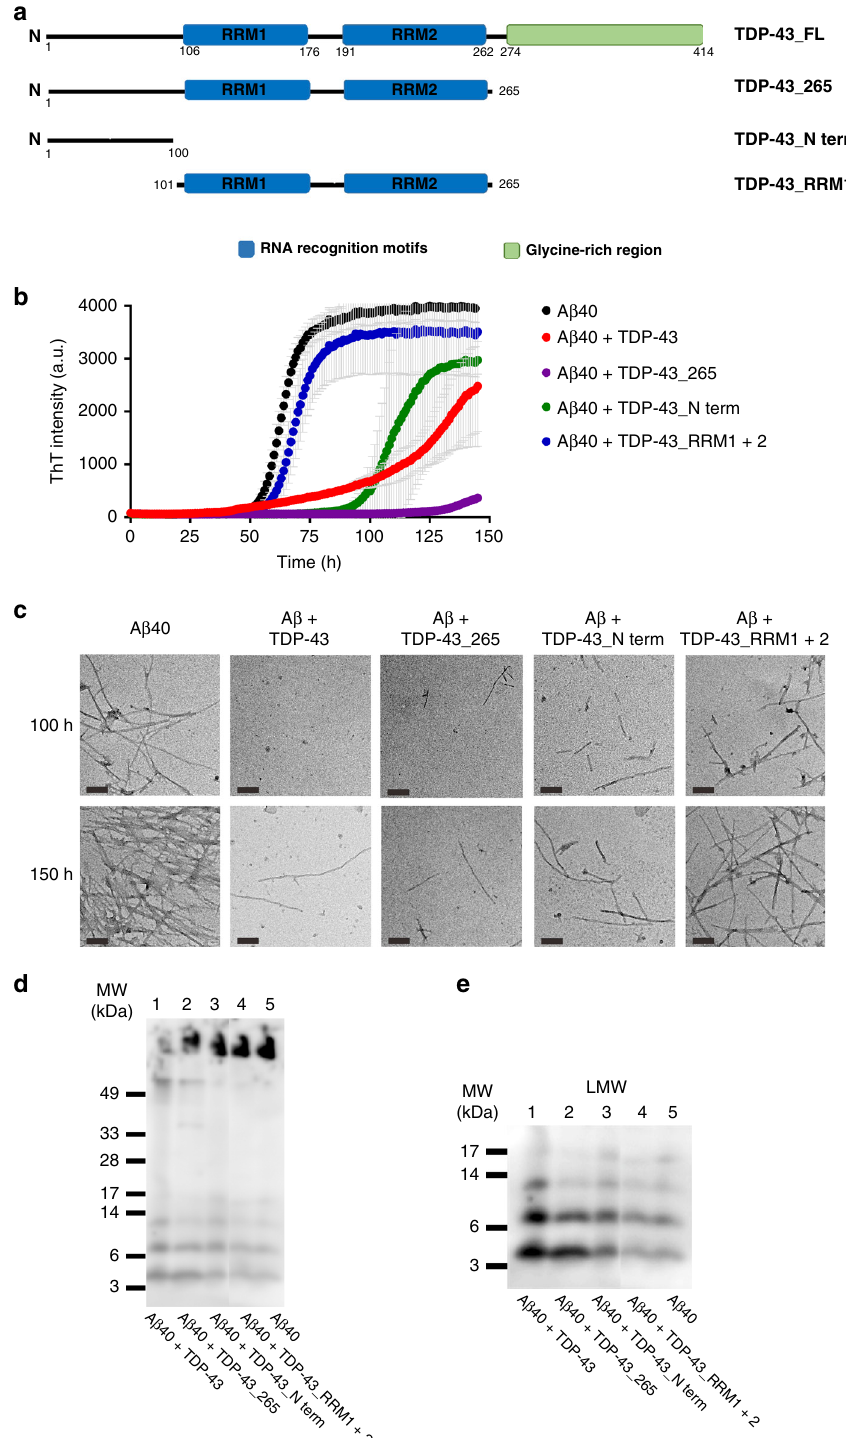
Fig. 2 Truncated TDP-43 variants inhibit A β fi brillization. a Illustration of the structural motifs of TDP-43. Full-length TDP-43 contains an N-terminal domain, two RNA recognition motifs (RRM1 and RRM2), and a glycine-rich region in its C-terminus. The constructs used in the study are shown. They are full-length TDP-43, TDP-43 aa 1 – 265 (TDP-43_265), TDP-43 aa 101-265 (TDP-43_RRM1 + 2), and TDP-43 aa 1 – 100 (TDP-43_N-term). b ThT assays of A β fi brillization (black) and with TDP-43 variants (TDP-43_FL, red; TDP-43_265, purple; TDP-43_N-term, green; TDP-43_RRM1 + 2, blue) in 10 mM Tris buffer, pH 8.0. A β 40 concentration was 25 μ M, and TDP-43 concentration was 0.25 μ M. The averaged data from three replicates and standard deviations are plotted. c TEM images of A β species with and without TDP-43 proteins. Two incubation time points, 100 h and 150 h were chosen for examination. The samples were loaded on SDS-PAGE d and then probed by anti-A β antibody, 6E10 to show the relative amounts of A β 40 amyloid fi brils. Two times of independent experiments were performed. e The enlarged area of Fig. 2d shows a clear band distribution of low-molecular-weight A β species. Source data are provided as a Source Data fi